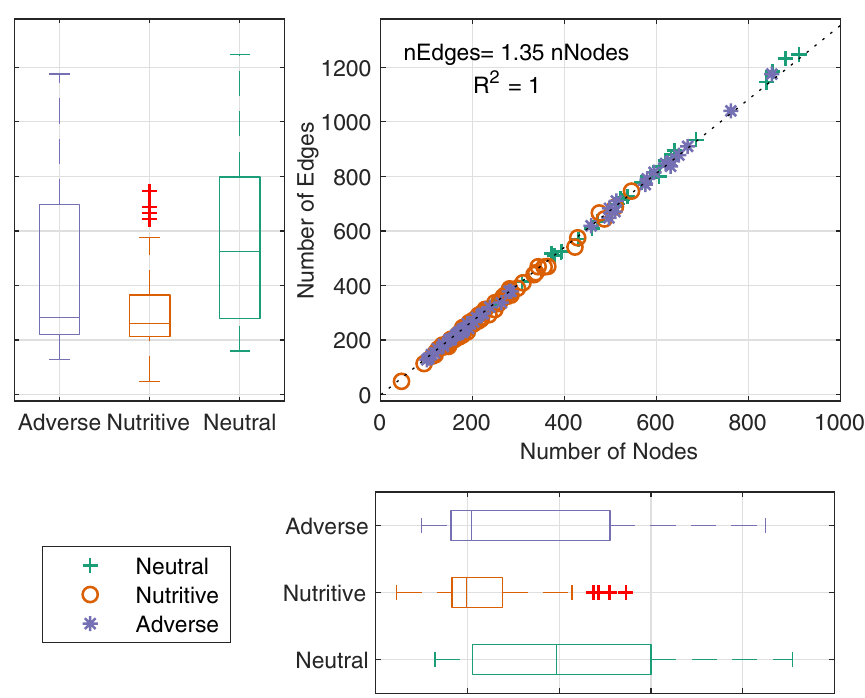
Figure 6. Number of nodes and edges in the network. Boxplots showing the variability of the number of Edges and Nodes in the networks by substrate. Scatter plot showing the linear relationship between the number of edges and nodes. Box plots show median (horizontal line), interquartile range (box), distance from upper and lower quartiles times 1.5 interquartile range (whiskers), and outliers ( > 1.5 x upper or lower